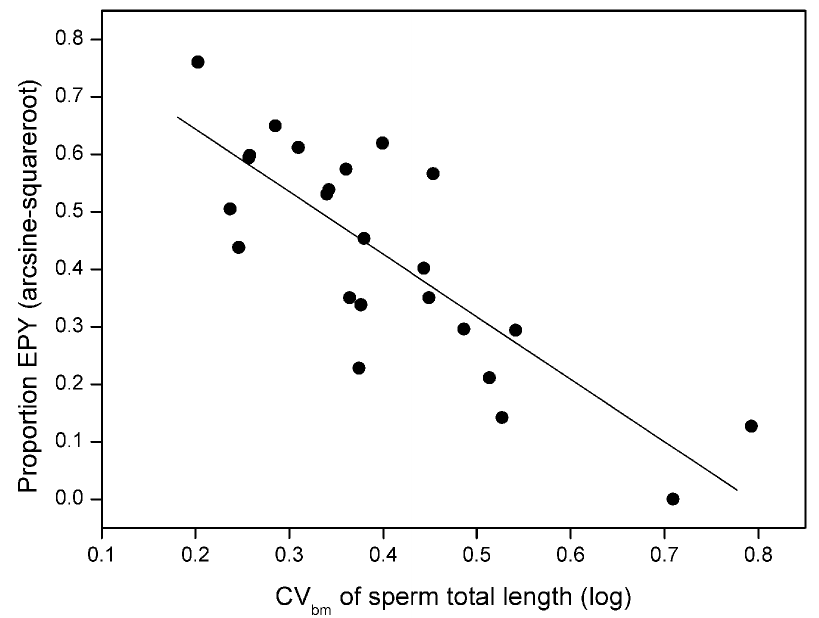
Figure 2. Relationship between extrapair paternity and between-male variation in sperm length. The figure illustrates the linear regression of the proportion of extrapair young on the coefficient of between-male variation in sperm length (CV bm ) for 24 passerine species in which paternity and sperm data originated from the same study population (raw data given in Table S1). Note that transformed values are used. The regression line (y=0.8614–1.0882 6 ; r 2 =0.66, P , 0.001) was used to calculate predicted extrapair paternity rates from CV bm values for all 55 species in the data set (see Table S1).